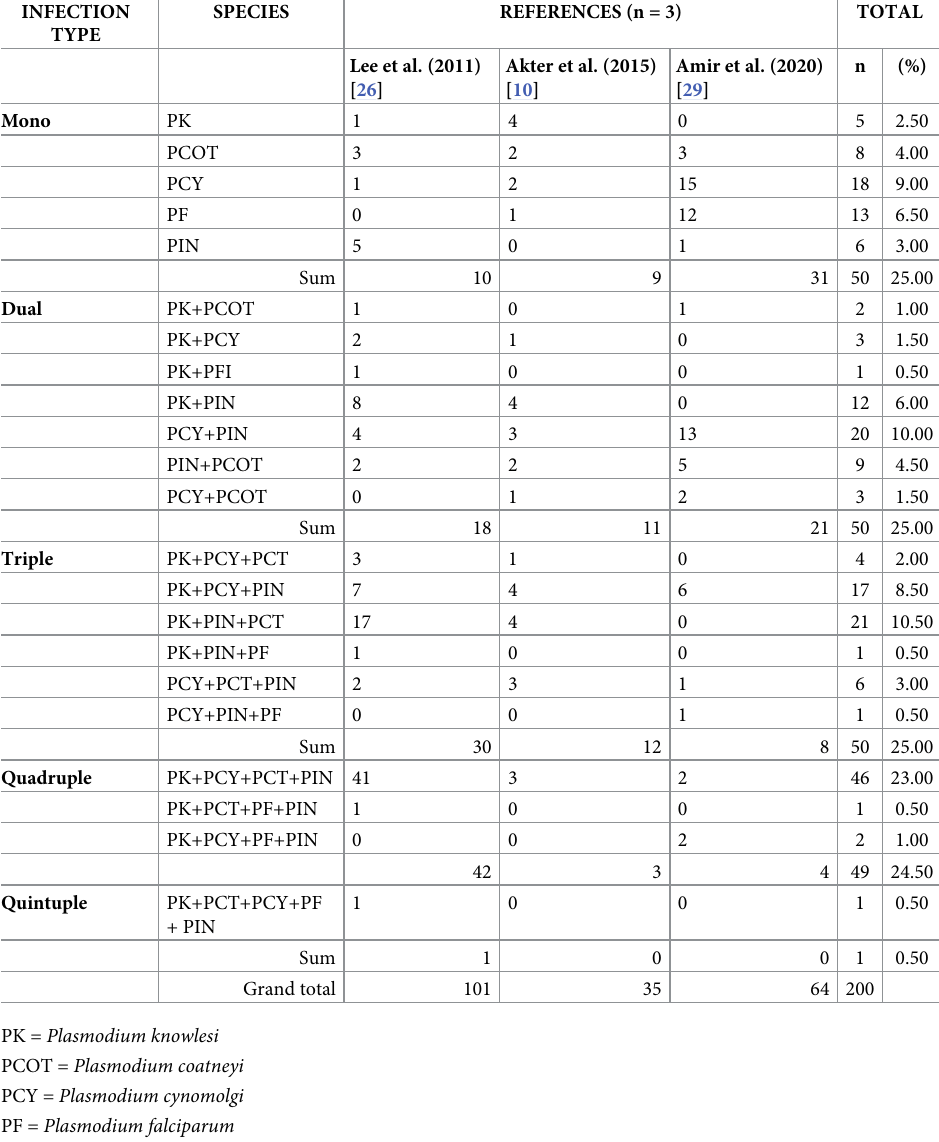
Table 4. The details breakdown of the plasmodia species in each infection type that comprise of mono, dual, tri- ple, quadruple and quintuple infection. INFECTION